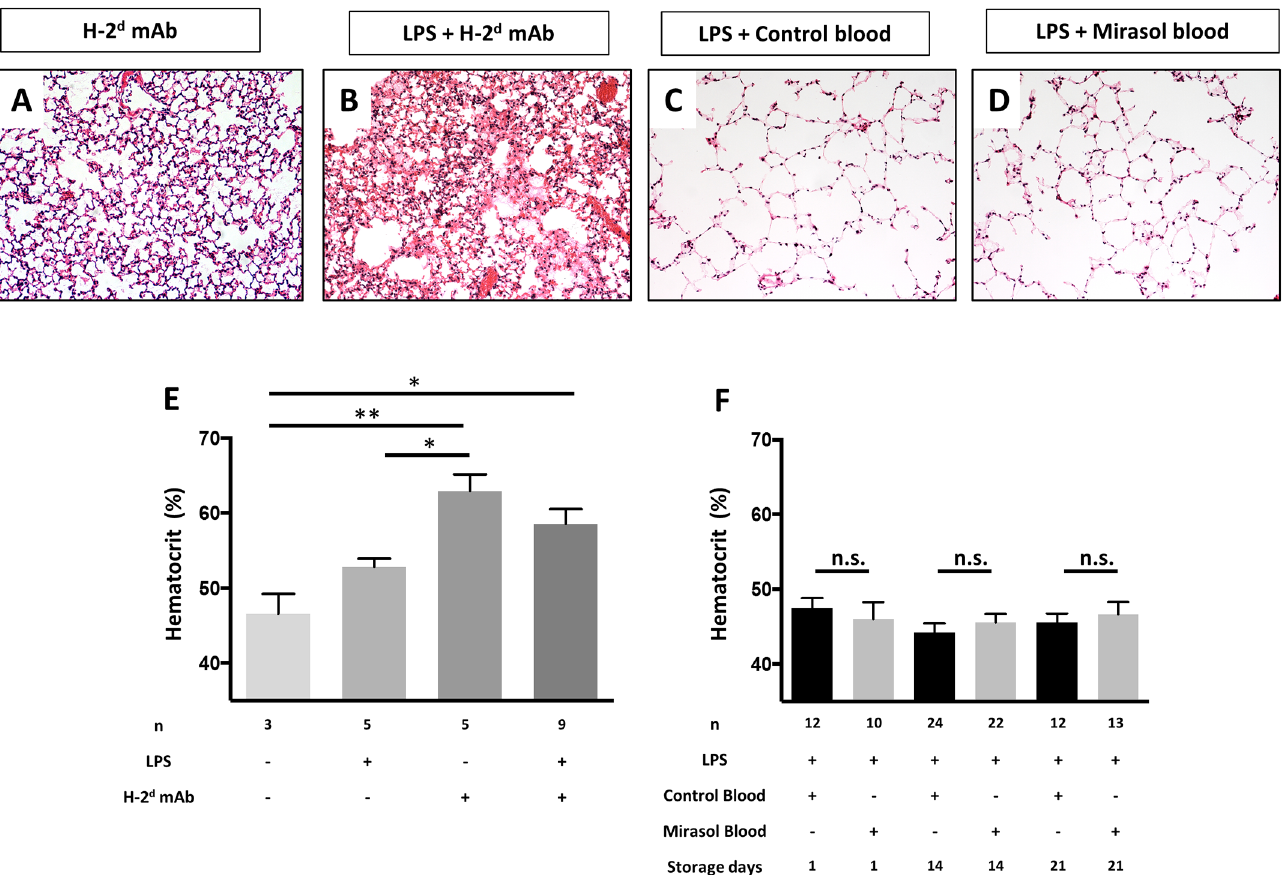
Fig 4. Representative lung histology and hematocrit values. H&E staining on lungsections from ( A ) BALB/c SCID mice + H-2 d mAb, ( B ) BALB/c SCID mice + LPS priming + H-2 d mAb, ( C ) BALB/c SCID mice + LPS primingand a 25% exchangetransfusionusing control human wholeblood (storage day 21), and ( D ) BALB/c SCID mice + LPS primingand a 25% exchangetransfusionusing Mirasol-PRT treated human wholeblood (storage day 21). Extensive lung injury (interstitial and alveolaredema, leukocyte infiltration)is observedin the TRALI groups ( A , B ), but no lung injury is detectablein either group of mice transfused with humanwhole blood ( C, D ). 20x magnification. ( E ) Hematocrit values in blood samples obtained from controls, TRALI, and ( F ) human wholeblood challengedanimals. Hemoconcentration is observedwith TRALI, but not in the other groups. Mean ± SEM. **** p < 0.0001, ** p < 0.01(ANOVA).